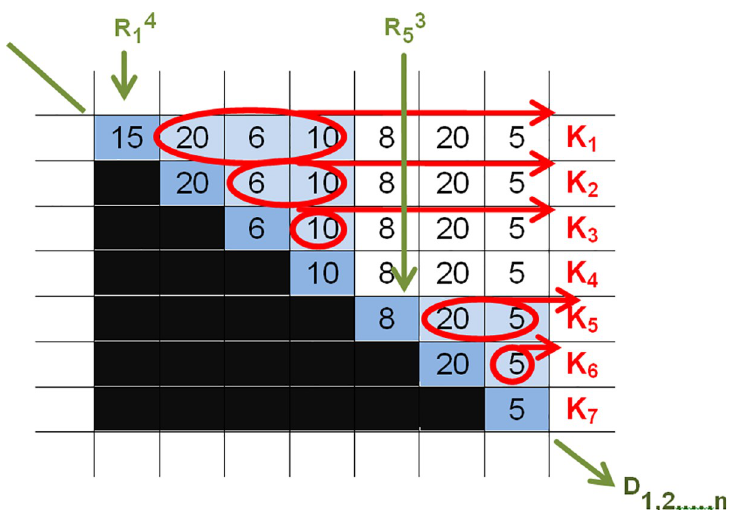
Fig 2. The topological representation of an order chain of two